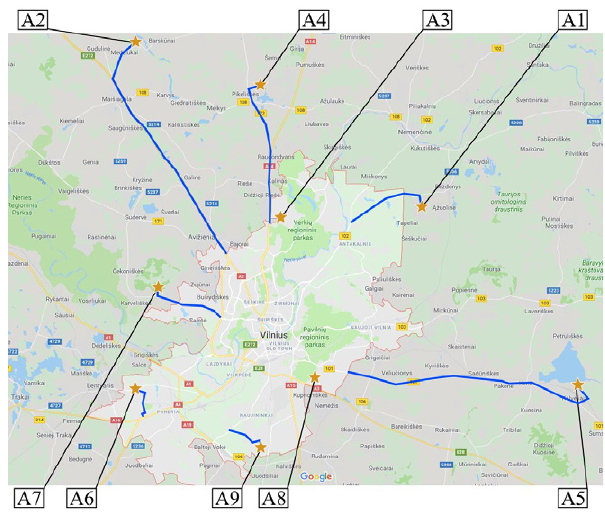
Figure 1. Chosen plots-alternatives in Vilnius city/suburb (The image is created according to an open data map,